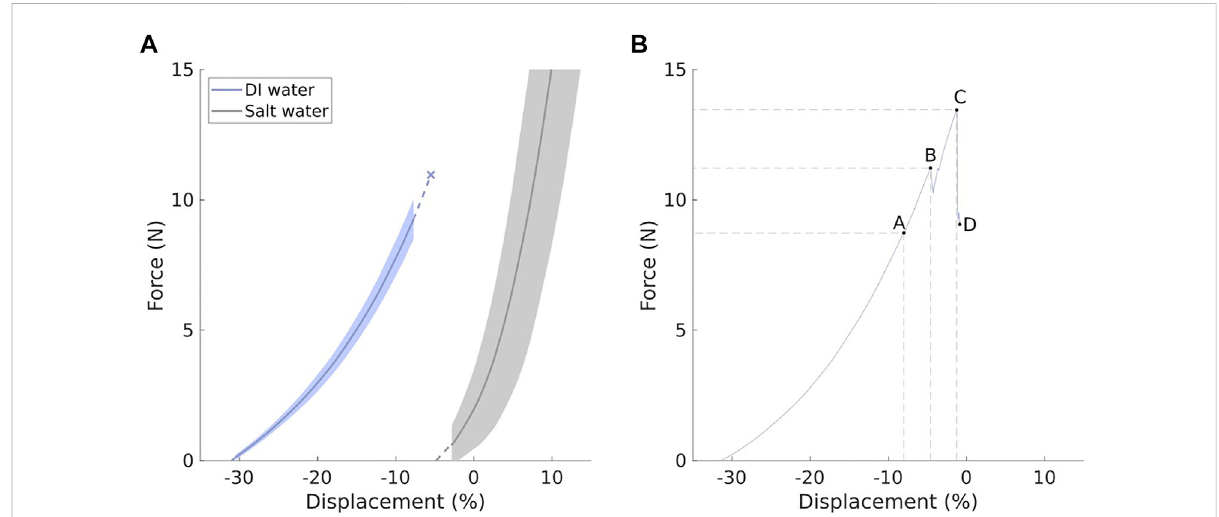
FIGURE 6 Results of SAP-BAM tensile testing. (A) Mean results (solid lines) for testing of SAP-BAM in fresh (DI) water (left) and salt water (right) conditions. Error bands show one standard deviation in the force reading. (B) Representative curve for one test in fresh water conditions. Labelled points show regions of interest, as discussed in section 3.2. Displacement in both (A) and (B) is calculated as a percentage relative to the length of newly- fabricated (dry)